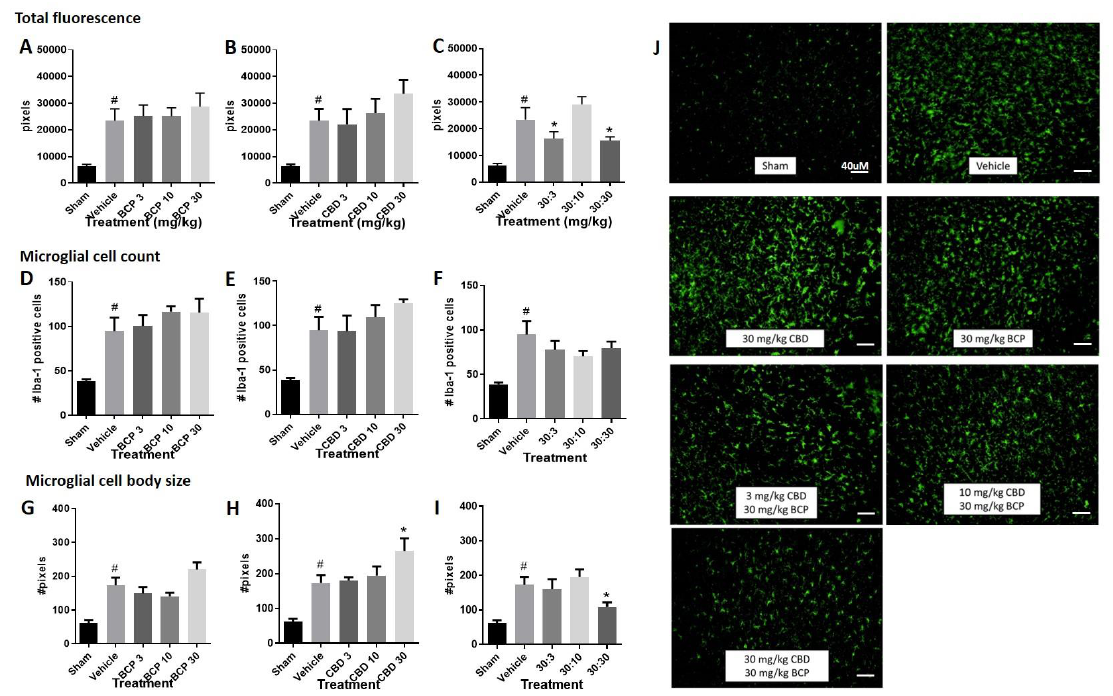
Figure 2. BCP or CBD single treatment increased Iba-1 immunofluorescence following photoinjury, while BCP + CBD combination treatment decreased Iba-1 immunofluorescence. ( A – C ) Quantification of Iba-1 immunofluorescence within the field of microscope images. ( D – F ) Quantification of microglial cell number within the field of microscope images. ( G – I ) Quantification of microglial cell body area (in arbitrary units determined using ImageJ) within the field of the microscope images. Data are expressed as mean and SEM. Statistical differences between sham (no stroke) and vehicle (stroke with vehicle treatment) were determined using Student t-test, # p < 0.05. Statistical differences across vehicle and cannabinoid-treated stroked mice were analyzed utilizing one-way ANOVA with Dunnett’s multiple comparison test to determine significance from vehicle treatment, * p < 0.05. ( J ) Representative immunohistochemical labeling for treatment groups are shown a 20 ×